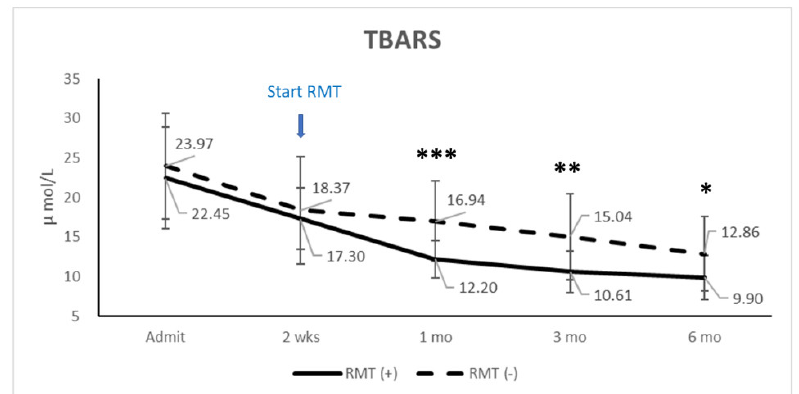
Figure 2. TBARS (present with mean and standard derivation) at admission, two weeks, one month, three months, and six months in patients who received or did not receive RMT. * p < 0.05; ** p ≤ 0.01; *** p ≤ 0.001, by two-way repeated measures